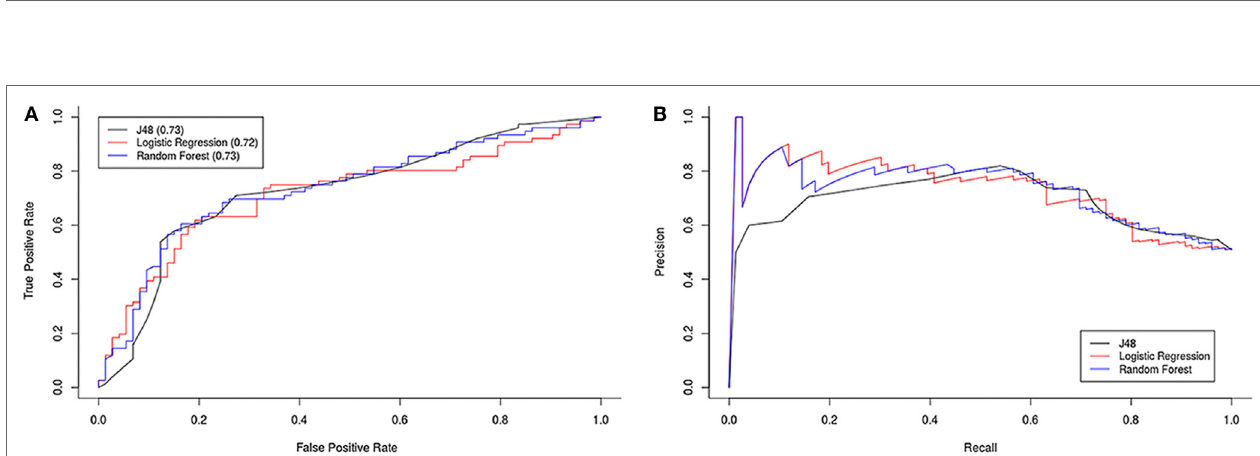
FigUre 6 | (a–e) Correlation analysis between immunophenotypes in patients (blue) and healthy controls (red). (F) Positive correlation between NKG2C and IgG-HCMV for both patients and controls, although more pronounced in the patients (controls rho = 0.48; myalgic encephalomyelitis/chronic fatigue syndrome rho = 0.18; p = 0.048).